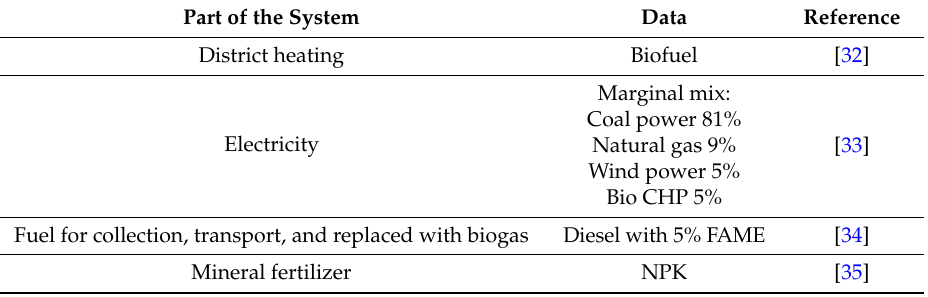
Table A11. Data on resource consumption and emissions for upstream (electricity and diesel) and compensatory production are from various selected references. FAME: fatty acid methyl